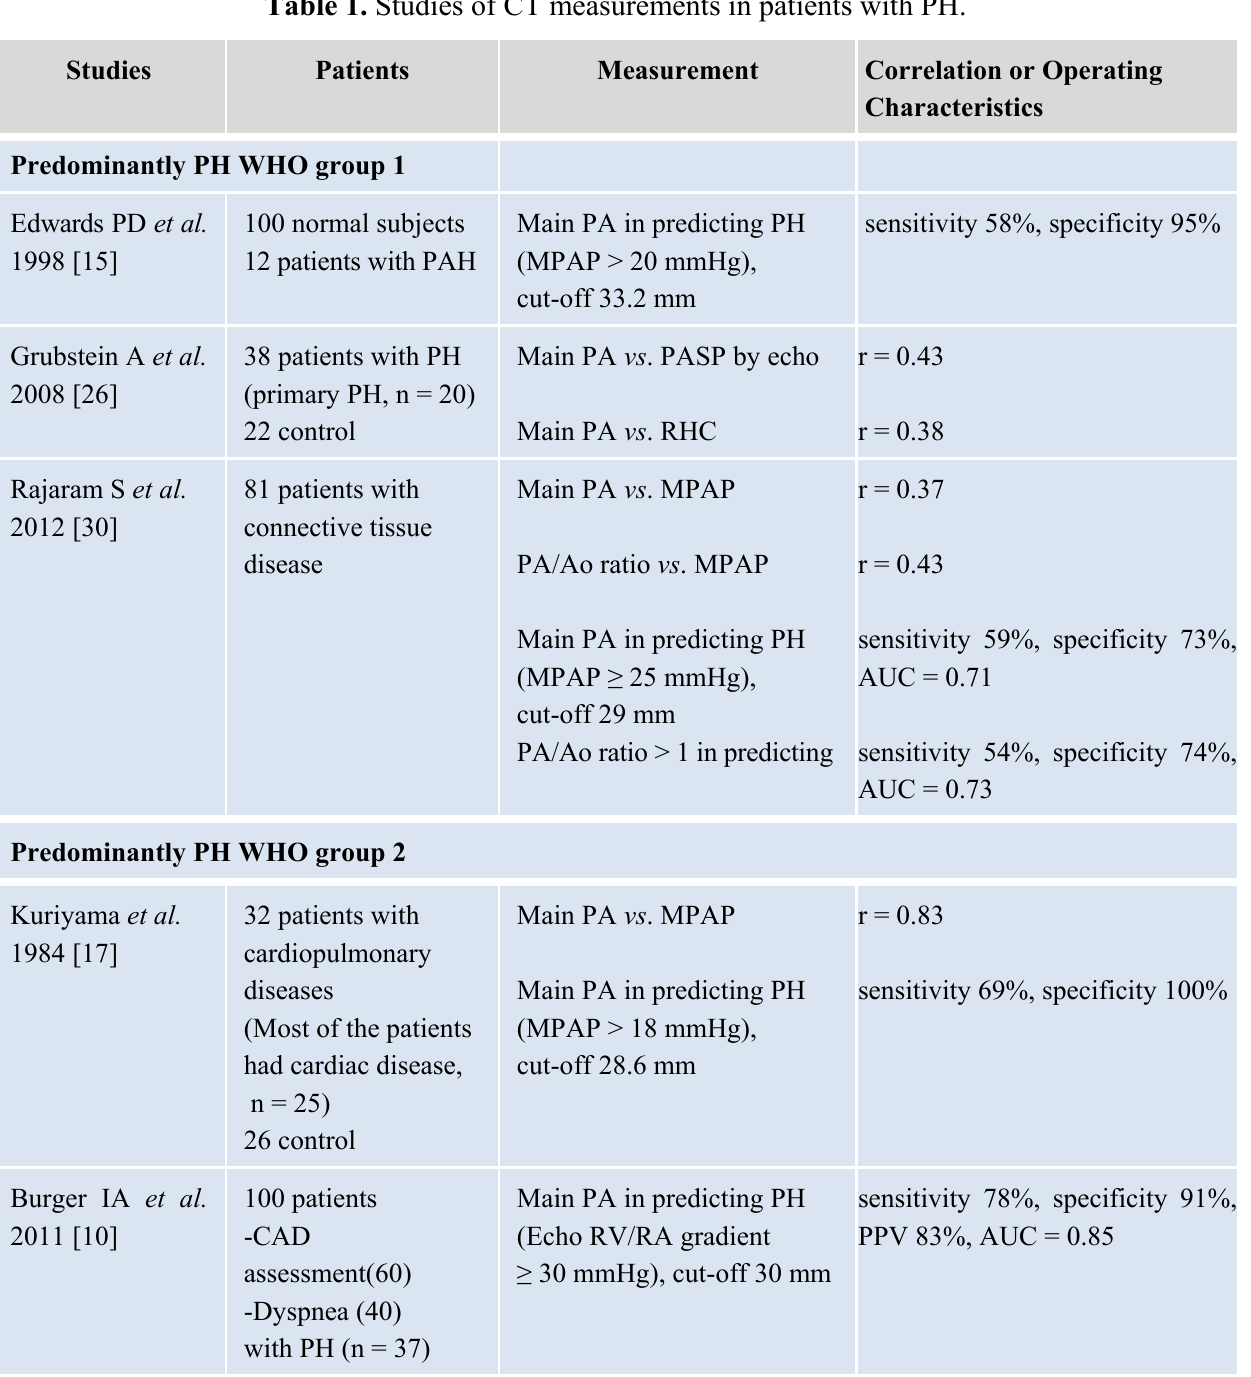
Table 1. Studies of CT measurements in patients with